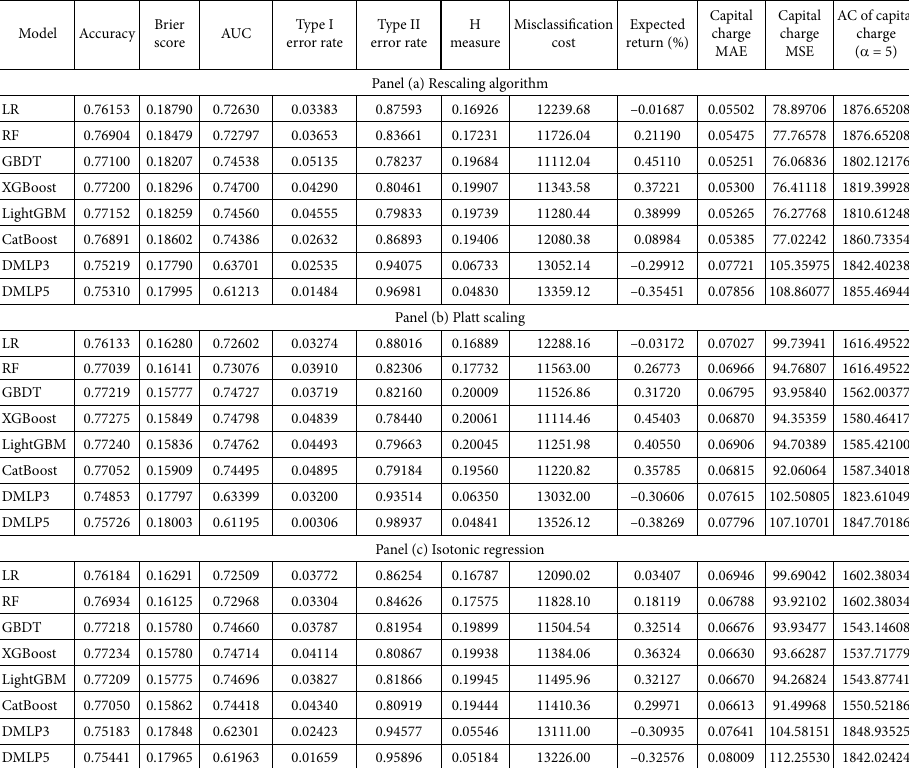
Table 9. Results of out-of-sample validation for Prosper dataset (with probability calibration) Model Accuracy Brier